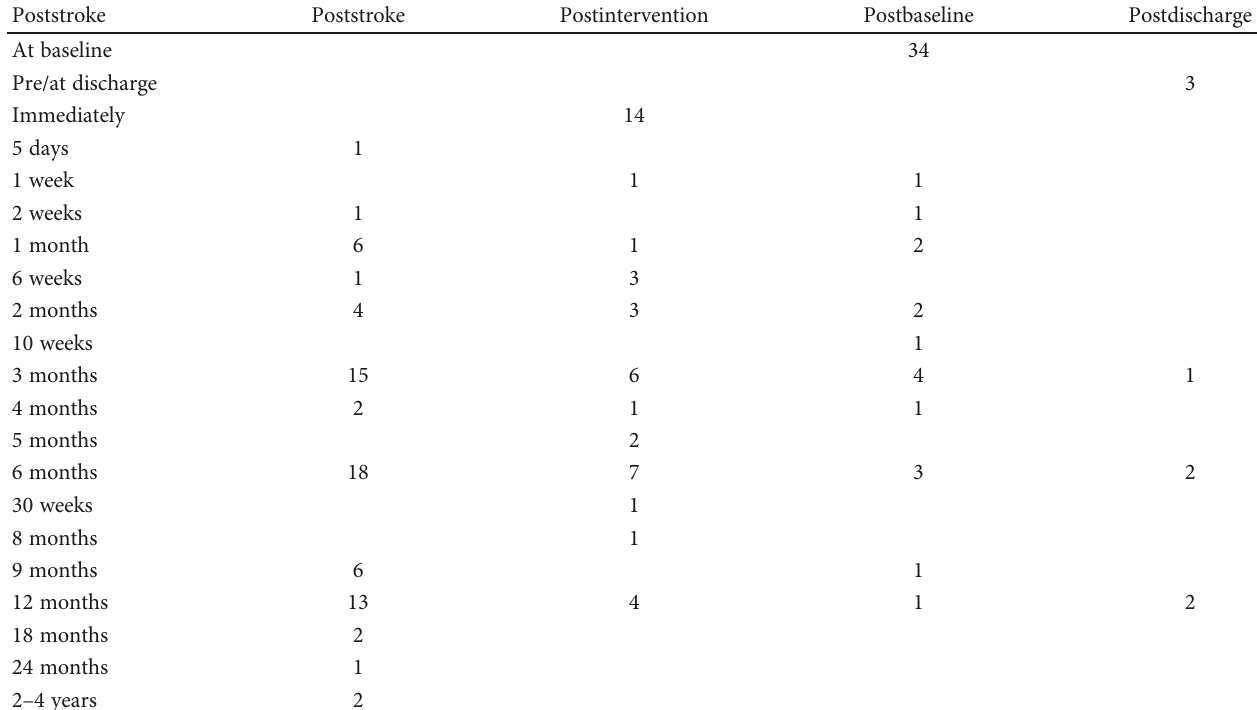
Table 3: Time point of participation measurement by authors measuring participation longitudinally after